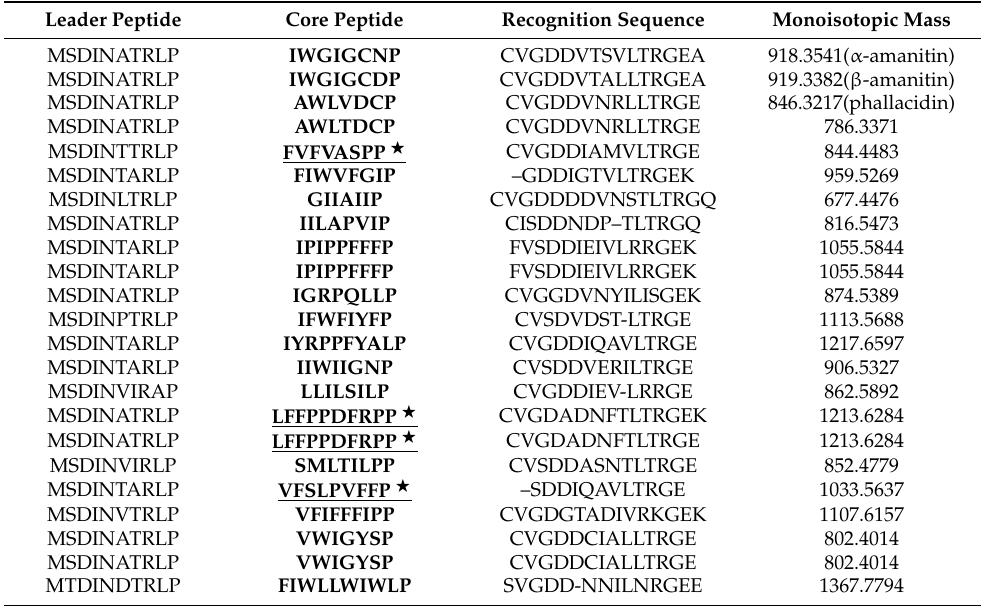
Table 2. The MSDIN gene family in Amanita exitialis.